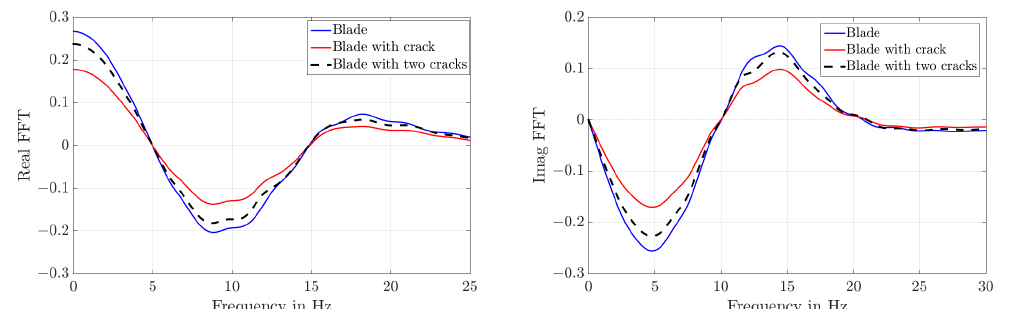
Figure 11. The real part and the imaginary part of the FFT for the signal are related to three different simple blades.